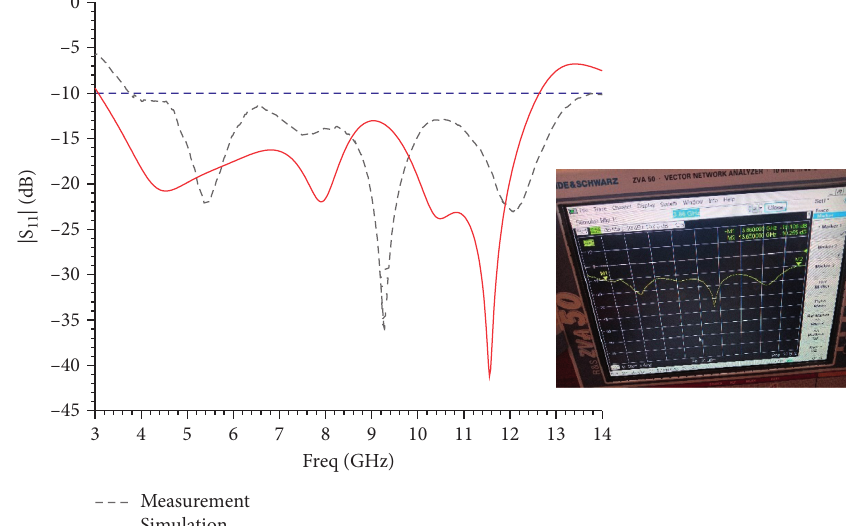
Figure 10: Reflection coefficient of VBi-UWBA.